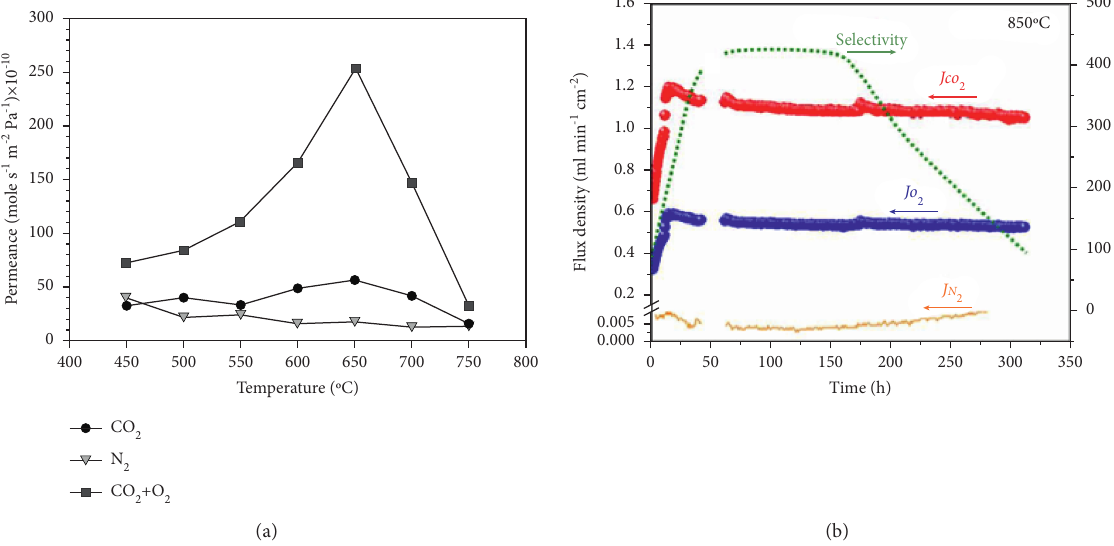
Figure 9: (a) Gas permeation of CO 2 , N 2 , and CO 2 +O 2 from a porous stainless steel support at different temperatures [12]. (b) Flux densities and selectivity of CO 2 and O 2 at 850 ° C with NiO support